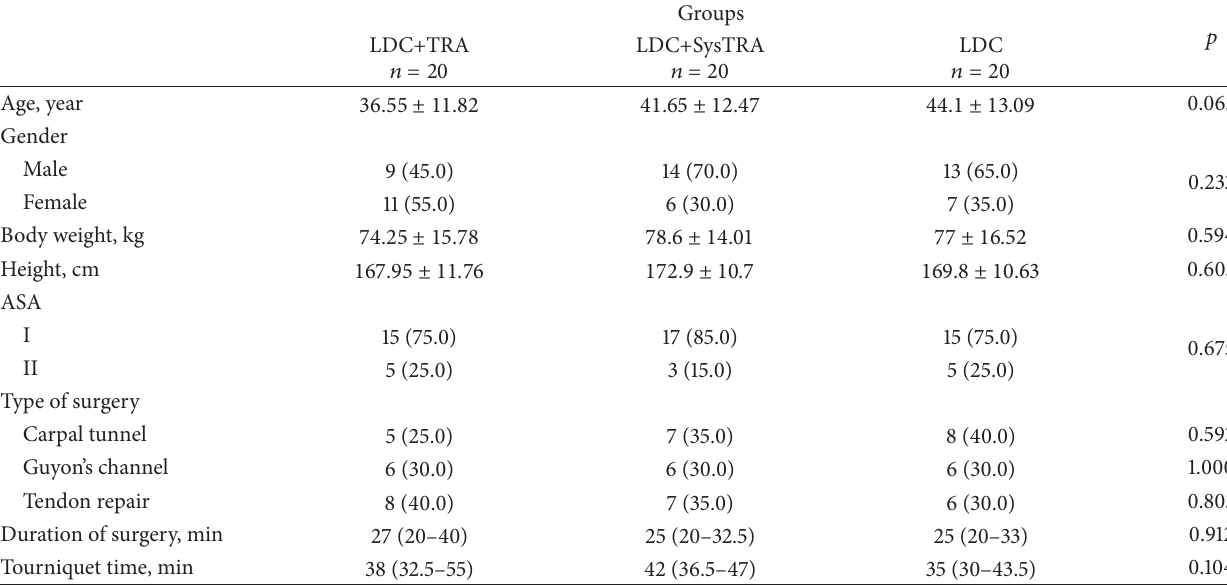
Table 1: General characteristics of the